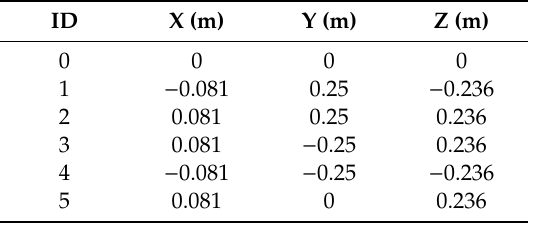
Figure 5. Image residuals (distortions) plotted on an image plane. Table 2. Target coordinates.